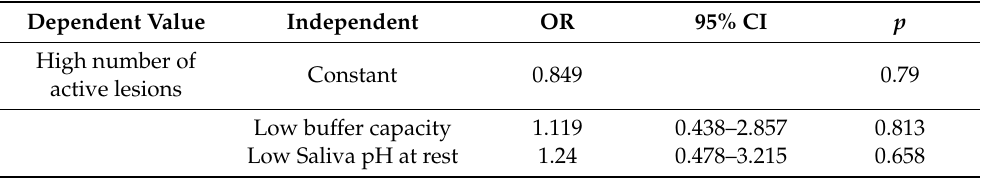
Table 3. Odds ratios (OR) and 95% confidence interval (CI) derived from logistic